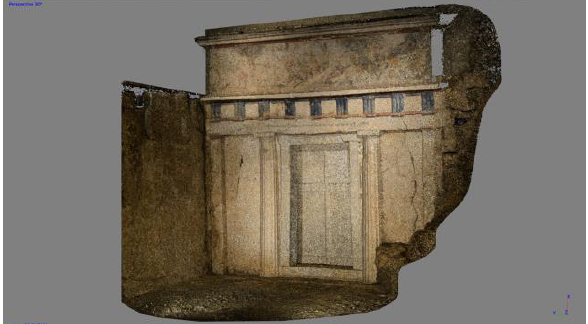
Figure 12. The Tomb of Alexander IV at Verghina. Cloud of points, detail from the